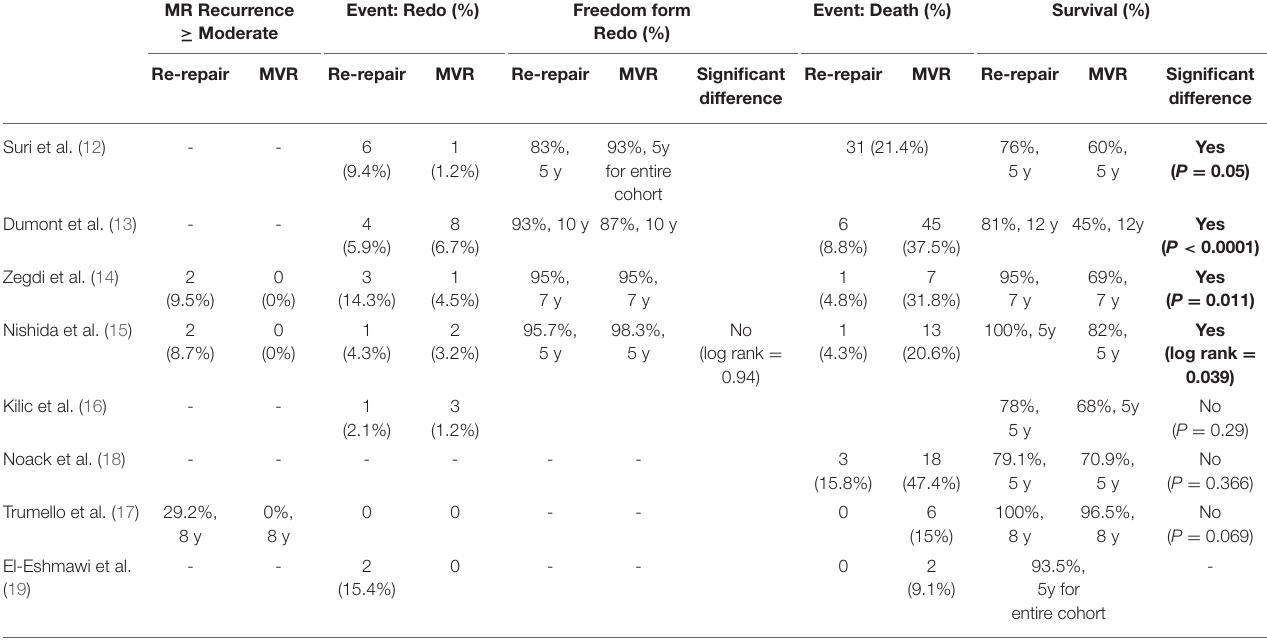
TABLE 4 | Long-term